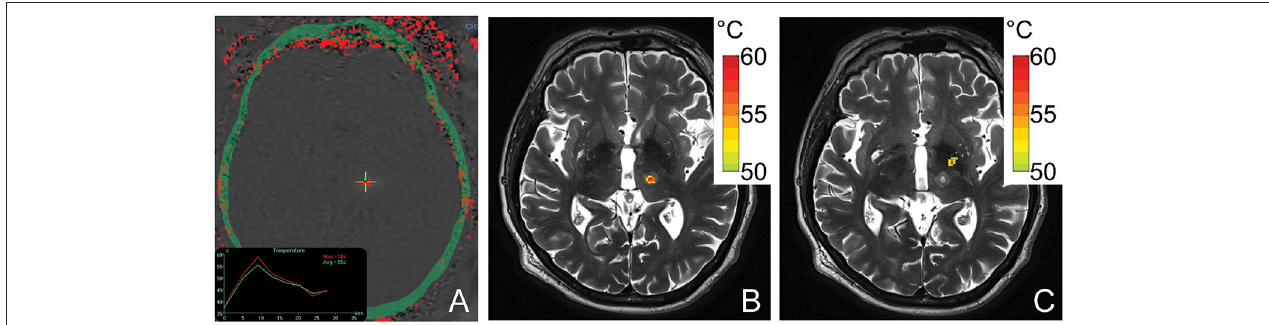
FIGURE 4 | An MR thermometry image acquired during the treatment of ET with focused ultrasound thalamotomy showing 58 ◦ C was achieved as the maximum temperature on this patient (A) . An example of temperature simulation results is shown when targeting VIM (B) and GPi (C) on the same patient. The temperature fields were registered to the post 1-day T2-weighted images. The globus pallidus internus lies antero-lateral compared to the ventral intermediate